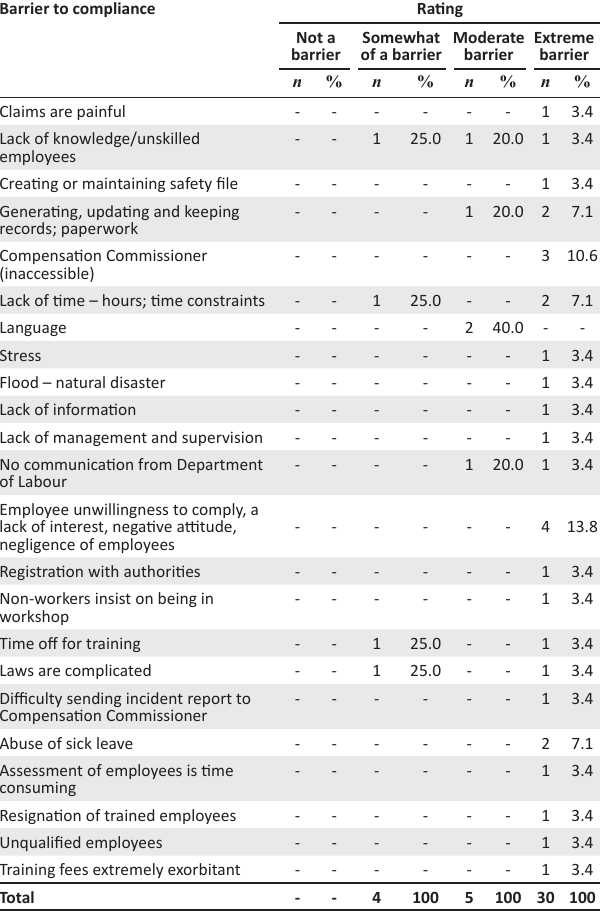
The inter-correlation of the barriers to OHS compliance indicated that the data were suitable for factor analysis.